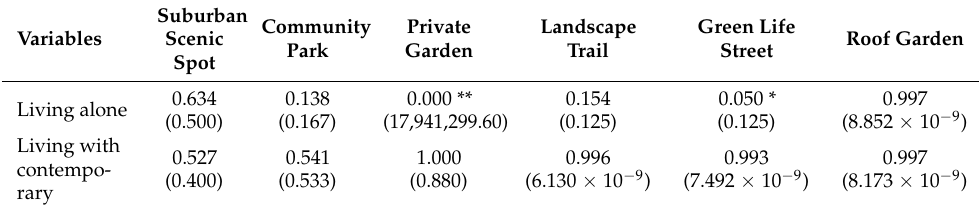
Table 5. The type of UGSs visited during the lockdown explained by residential